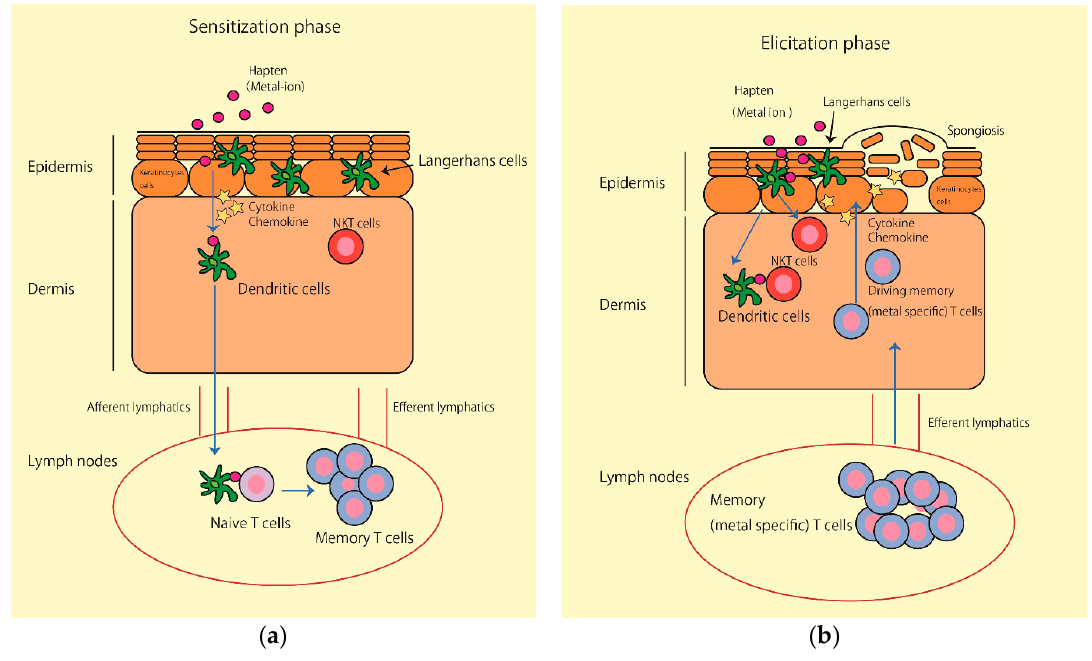
Figure 1. Schematic mechanism of metal ion–induced allergic contact dermatitis. ( a ) Sensitization phase in metal allergy. Step 1: Metal ions form complexes with partner molecules within the body, thereby becoming antigens. A hapten (metal ion) combines with a native protein and activates keratinocytes (KCs), cutaneous Langerhans cells (LCs), and dermal dendritic cells (DCs) through the innate immune system; Step 2: Activated DCs capture antigens, mature, and migrate to the regional lymph nodes via afferent lymphatics; Step 3: Migrated DCs present antigens to naive T cells in draining lymph nodes. NK T cells affect DC functions and regulate the excessive immune response; ( b ) Elicitation phase in metal allergy. Step 1: KCs are activated by re-exposure to haptens and produce various cytokines and chemokines that activate endothelial cells and draining memory metal-specific T cells; Step 2: Infiltrated metal-specific effector T cells are activated and produce proinflammatory cytokines and chemokines that activate KCs and induce further inflammatory cell infiltration; Step 3: NK T cells may regulate the excessive acquired immune response caused by metal-specific effector T cells.